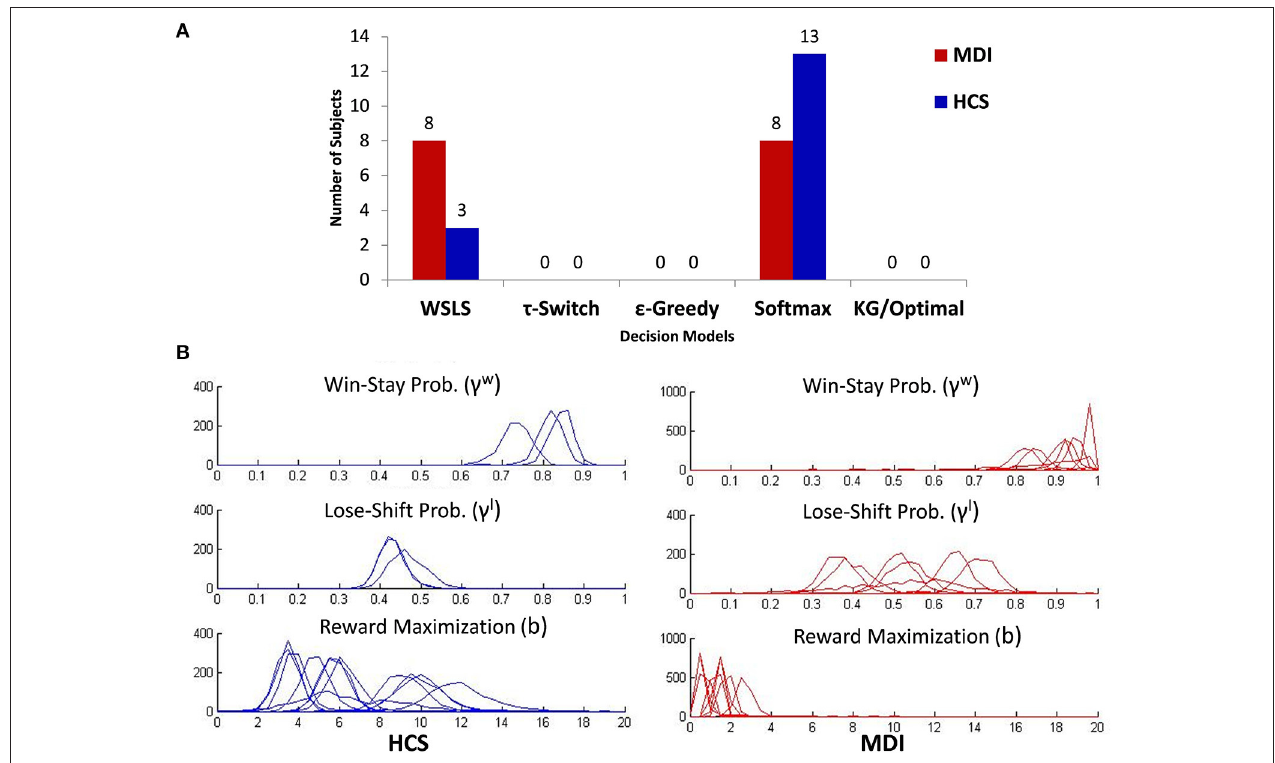
FIGURE 4 | (A) Classification of all subjects by group (MDI, methamphetamine dependent individuals; HCS, healthy comparison subjects) and model usage based on posterior mode of the z ijk parameter. (B) Posterior distributions for the parameters associated with the strategic control model used by participants: Win-Stay/Lose-Shift (WSLS; γ w γ l : top two graphs) and Softmax ( b parameter; bottom graph). The y-axis depicts a histogram of the counts of MCMC samples obtained for each of these parameters for each individual (overlaid) identified to be most likely to be using the corresponding